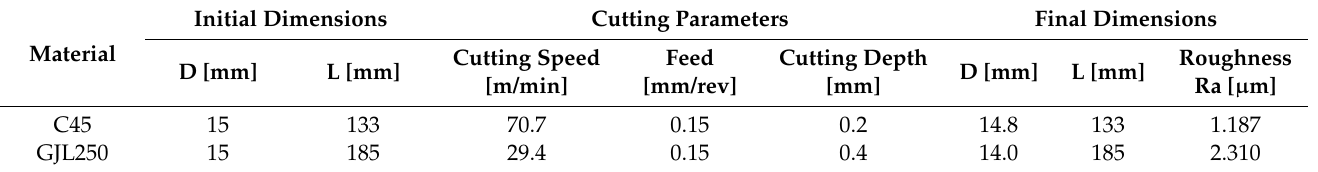
Table 1. Cutting parameters and specimen dimensions (initial and final).